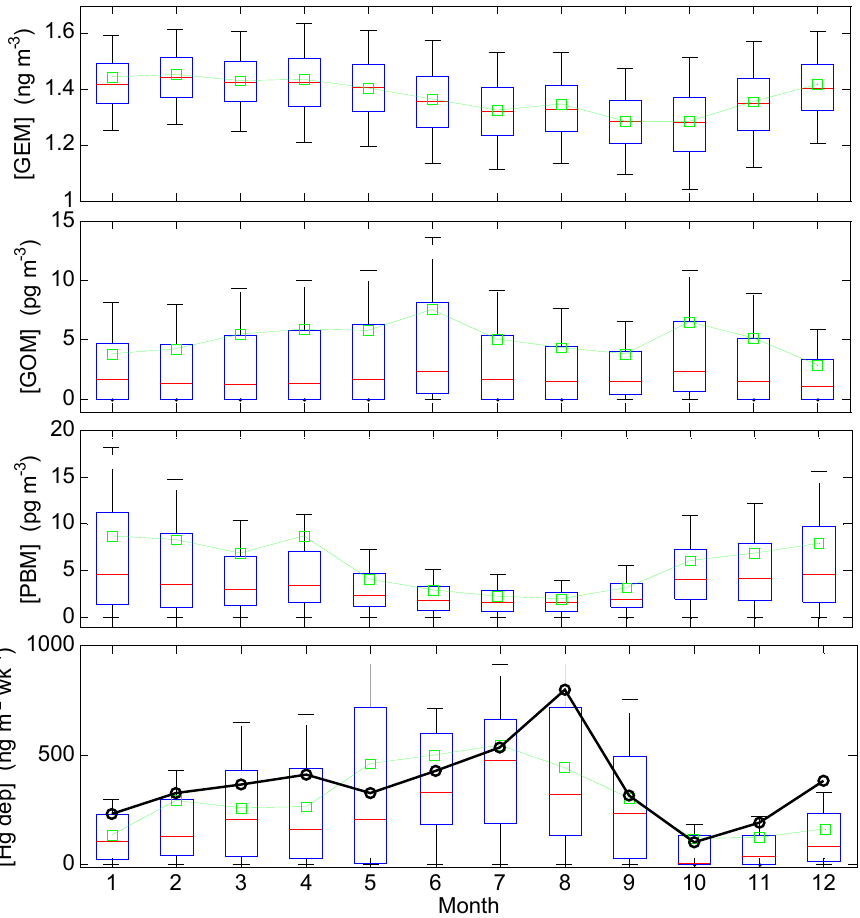
Figure 6. Boxplots showing composite seasonal variations of GEM, GOM, PBM, and Hg wet deposition measured at the Grand Bay site from 2007 to 2018. On each box, the central mark is the median, the edges of the box are the 25th and 75th percentiles, and the whiskers extend to the 5th and 95th percentiles. The linked green squares are composite monthly means. The linked black circles in the bottom panel are the composite monthly precipitation amounts (units: mm × 5).